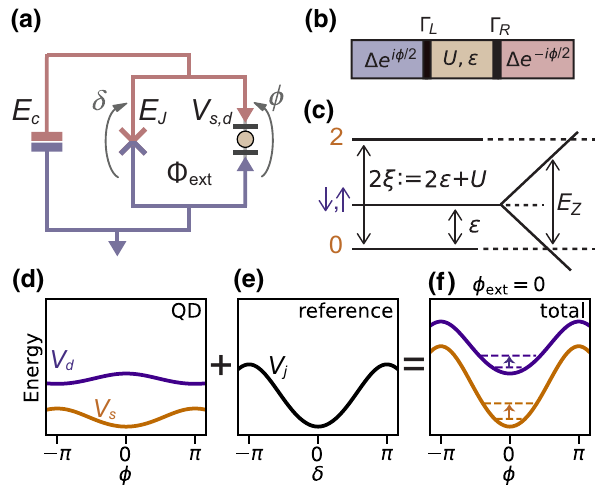
FIG. 1. (a) A schematic diagram of a quantum dot junction incorporated into a transmon circuit. The transmon island with charging energy E c is connected to ground by a SQUID formed by the parallel combination of a quantum dot junction and a reference junction. Here, φ and δ denote the superconducting phase difference across the quantum dot and reference junctions, respectively. (cid:5) ext is the externally applied magnetic flux through the SQUID loop. (b) A model diagram of the quantum dot junc- tion in the excitation picture. Two s -wave superconductors are connected via tunnel barriers to a single-level quantum dot. (c) A level diagram of the quantum dot hosting zero, one, or two elec- trons when disconnected from the leads ( (cid:6) L = (cid:6) R = 0). (d) The phase dependence of the Josephson potential of the quantum dot junction in the singlet (orange) and doublet (purple) state. (e) The Josephson potential of the reference junction. (f) The Josephson potential of the dc SQUID for φ ext = ( 2 e / (cid:2) )(cid:5) ext = 0, with the quantum dot junction in the singlet (orange) and doublet (purple) state. The dashed lines represent the two lowest transmon energy levels in each branch of the Josephson potential, with the arrow denoting the resulting transition frequency, which can differ for the two quantum dot junction states (orange and purple arrows for singlet and doublet,